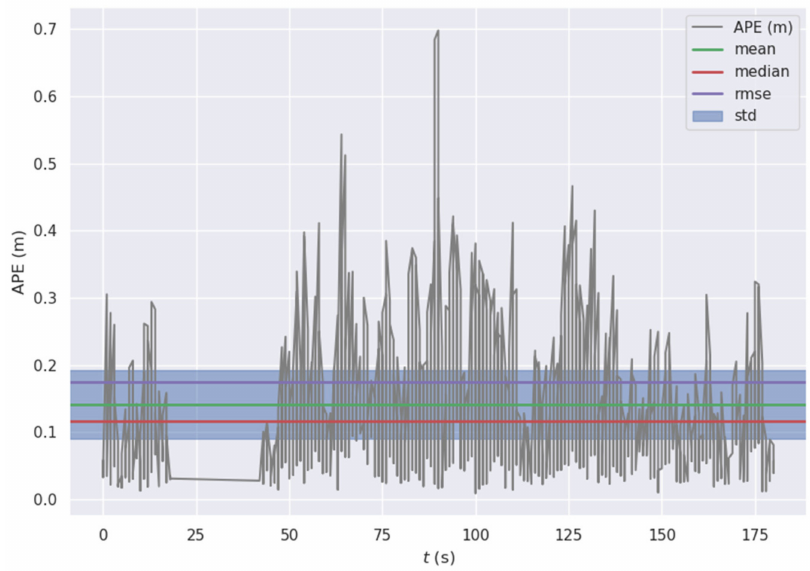
Figure 8. The change of absolute pose error (APE) as time goes on in sequence MH01.